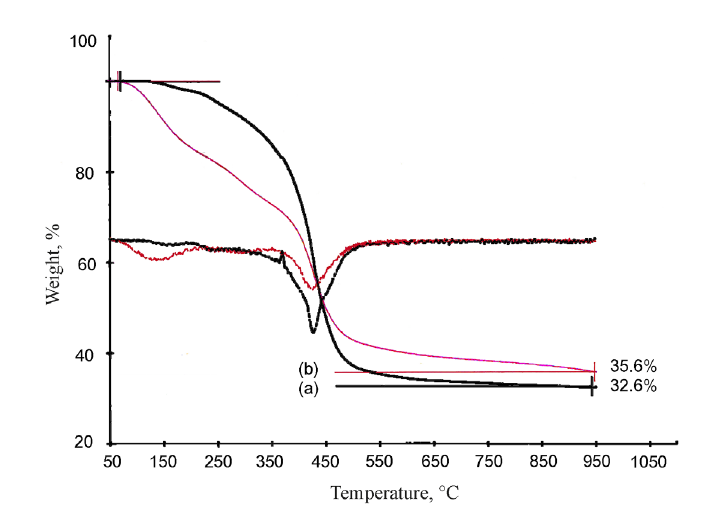
Fig. 4. Thermograms of the pitches: (a) PHT70, (b)